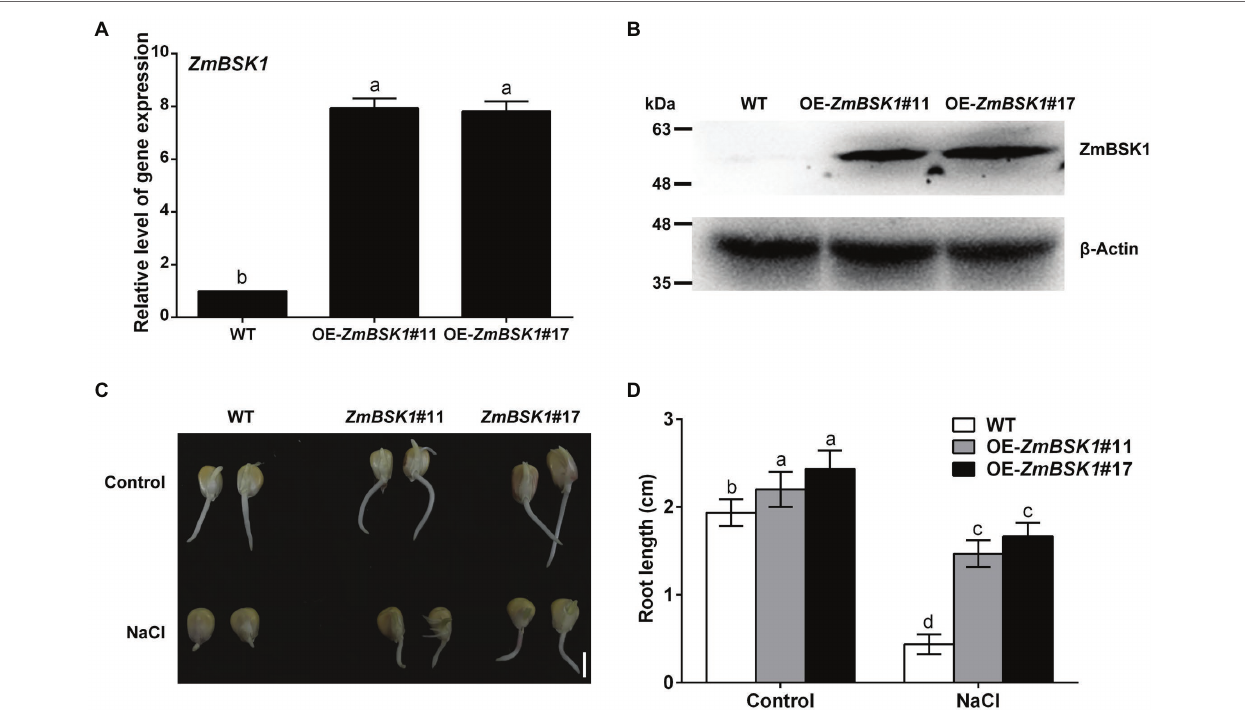
FIGURE 2 | Effect of ZmBSK1 on root growth of maize seeds under salt stress. (A) The expression levels of ZmBSK1 in OE- ZmBSK1 and wild type (WT) plants. The expression of ZmBSK1 was measured by qRT-PCR, and ZmActin2 served as an internal control. (B) The protein levels of ZmBSK1 in OE- ZmBSK1 and WT plants. Total proteins extracted from the leaves were used for immunoblotting with anti-Flag antibody. β -actin was used as a loading control. (C) The root growth phenotypes of OE- ZmBSK1 and WT maize seeds under salt stress. The maize seeds were spread on paper containing 200 mM NaCl for 4 days during germination. Scale bar = 1 cm. (D) Statistical analysis of root length in (C) . Error bars in (A,D) represent ±SD ( n = 3). Different letters indicate significant differences at p < 0.05 according to one-way or two-way ANOVA (Duncan’s multiple range